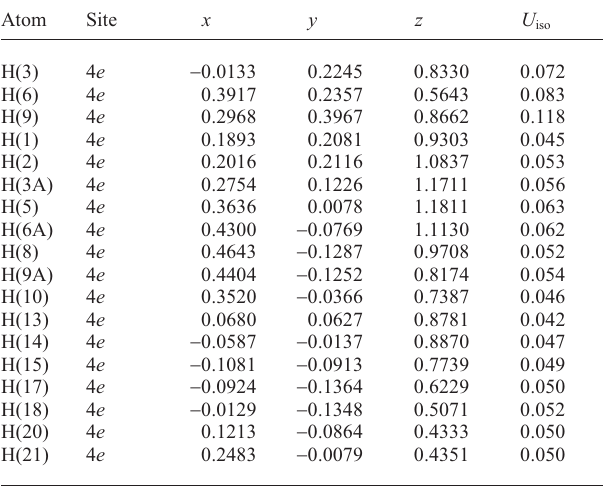
Table 2. Atomic coordinates and displacement parameters (in Å 2 )